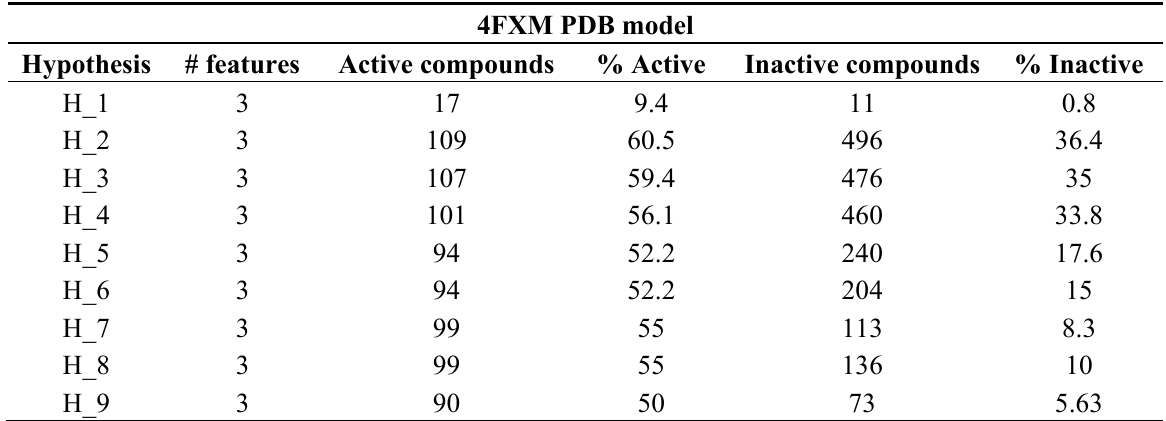
Table 3. Classification of the pharmacophore hypotheses generated by 4FXM PDB model.